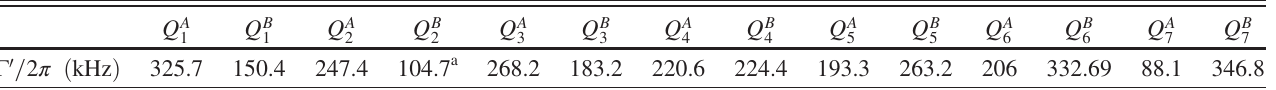
TABLE I. Qubit coherence in the middle band gap. The parasitic decoherence rate Γ 0 of qubits on device I at 6.621 GHz inside the MBG. The data for Q B 2 were taken in a separate cooldown due to coupling to a two-level system